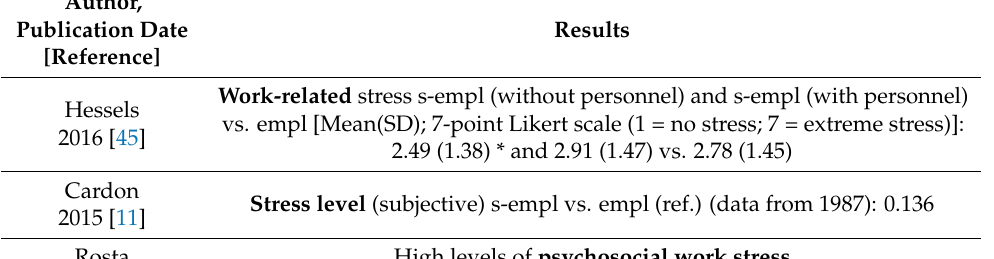
Table 9. Stress, burnout, exhaustion —results of cross-sectional studies of good quality on mental disorders comparing self-employed (s-empl) vs. employees